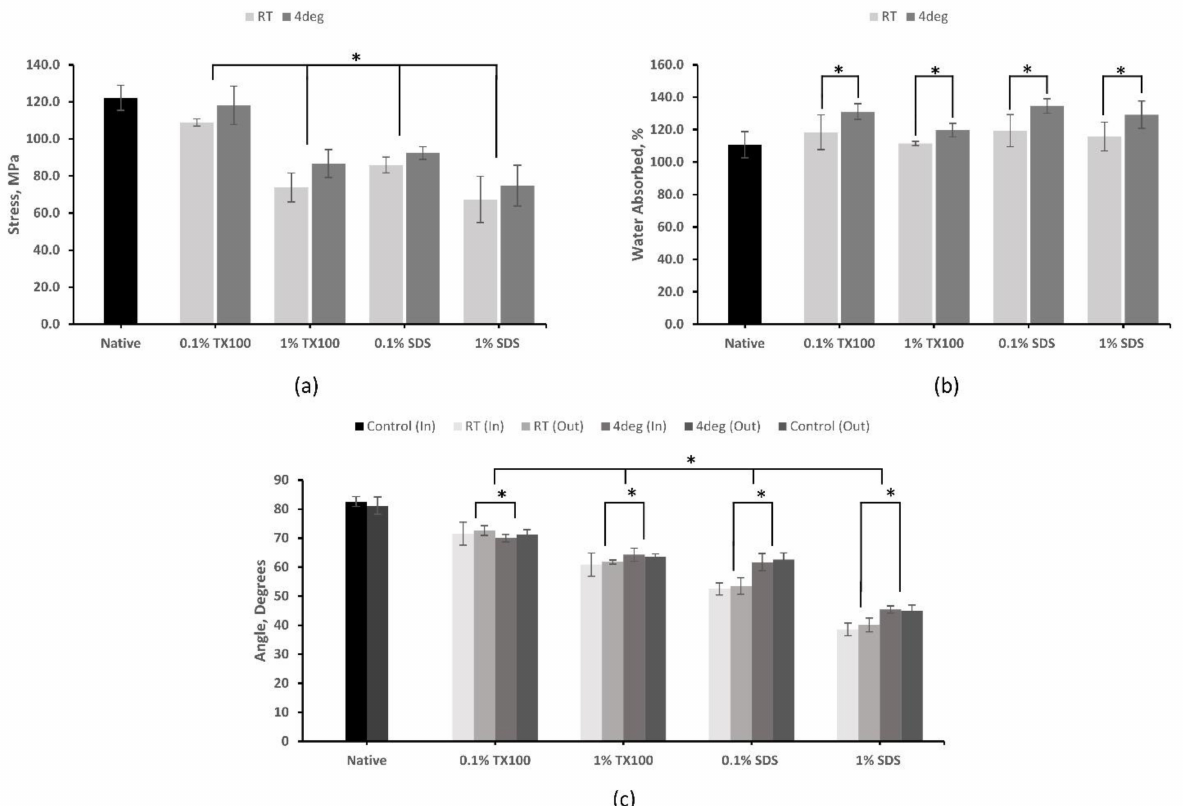
Figure 4. Physical and mechanical tests of native and decellularized milkfish skin: ( a ) tensile strength; ( b ) water absorption test; ( c ) hydrophilicity test measured using water contact angle. Bars represent standard deviation ( n = 3). * p <